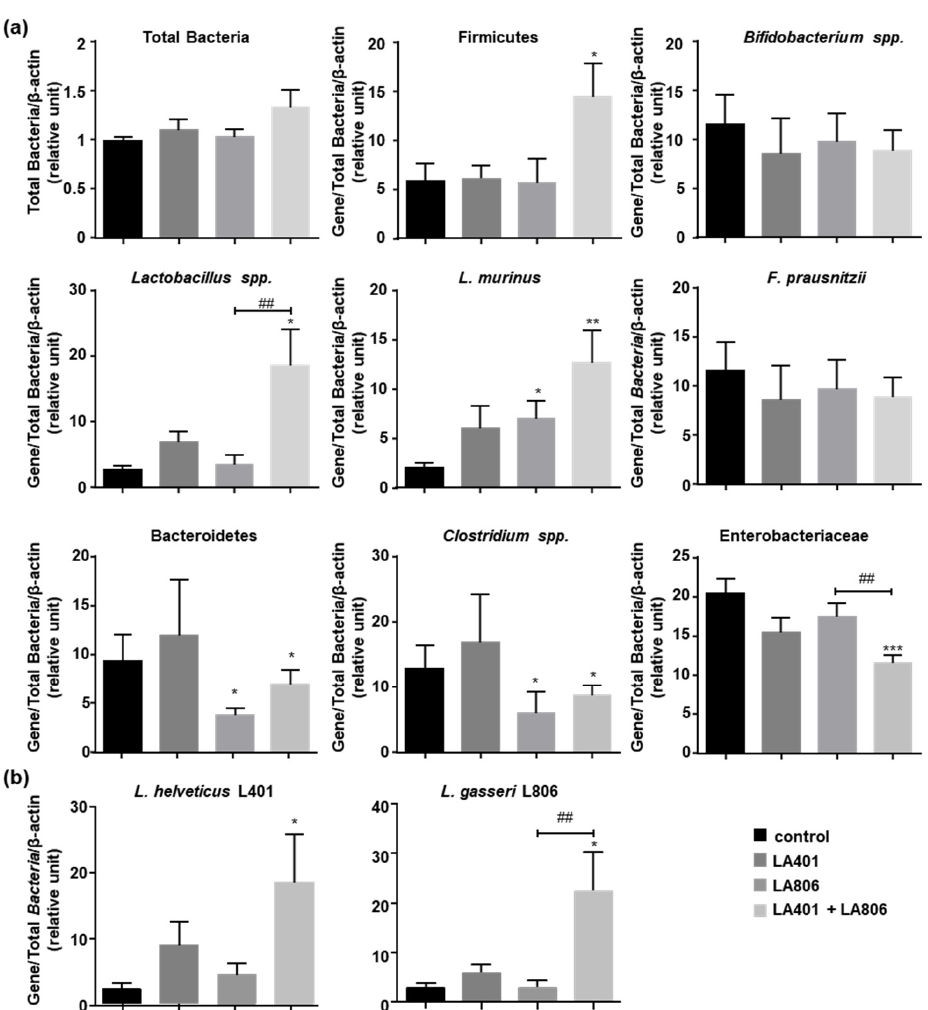
Figure 2. Impact of Lactobacillus helveticus LA401 and/or Lactobacillus gasseri LA806 oral administra- tion on the colonic microbiota of C. albicans -infected mice. ( a ) The relative abundance of phyla, genus and bacteria species in the colonic mucosa of Candida albicans -infected mice treated with the bacterial strains (LA401, LA806 and the combination of LA401 and LA806) or not (control) was evaluated by RT-PCR. ( b ) Relative abundance of L. helveticus LA401 and L. gasseri LA806 in colonic mucosa of C. albicans infected-mice was evaluated by RT-PCR. Values were normalized to total bacteria and host β -actin. Primers are listed in Table 1. n = 10 per experimental group. Data are presented as means ± SEM. * p ≤ 0.05, ** p ≤ 0.01, *** p ≤ 0.005 compared to control. ## p ≤ 0.01 compared to treatments.